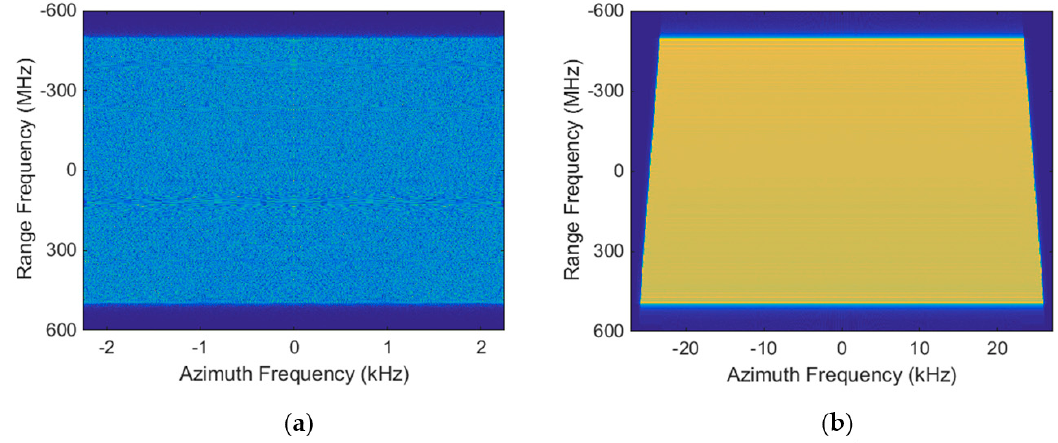
Figure 6. 2D Spectrum of single point target. ( a ) 2D spectrum without application of modified deramping-based approach; ( b ) 2D spectrum with application of modified deramping-based approach.